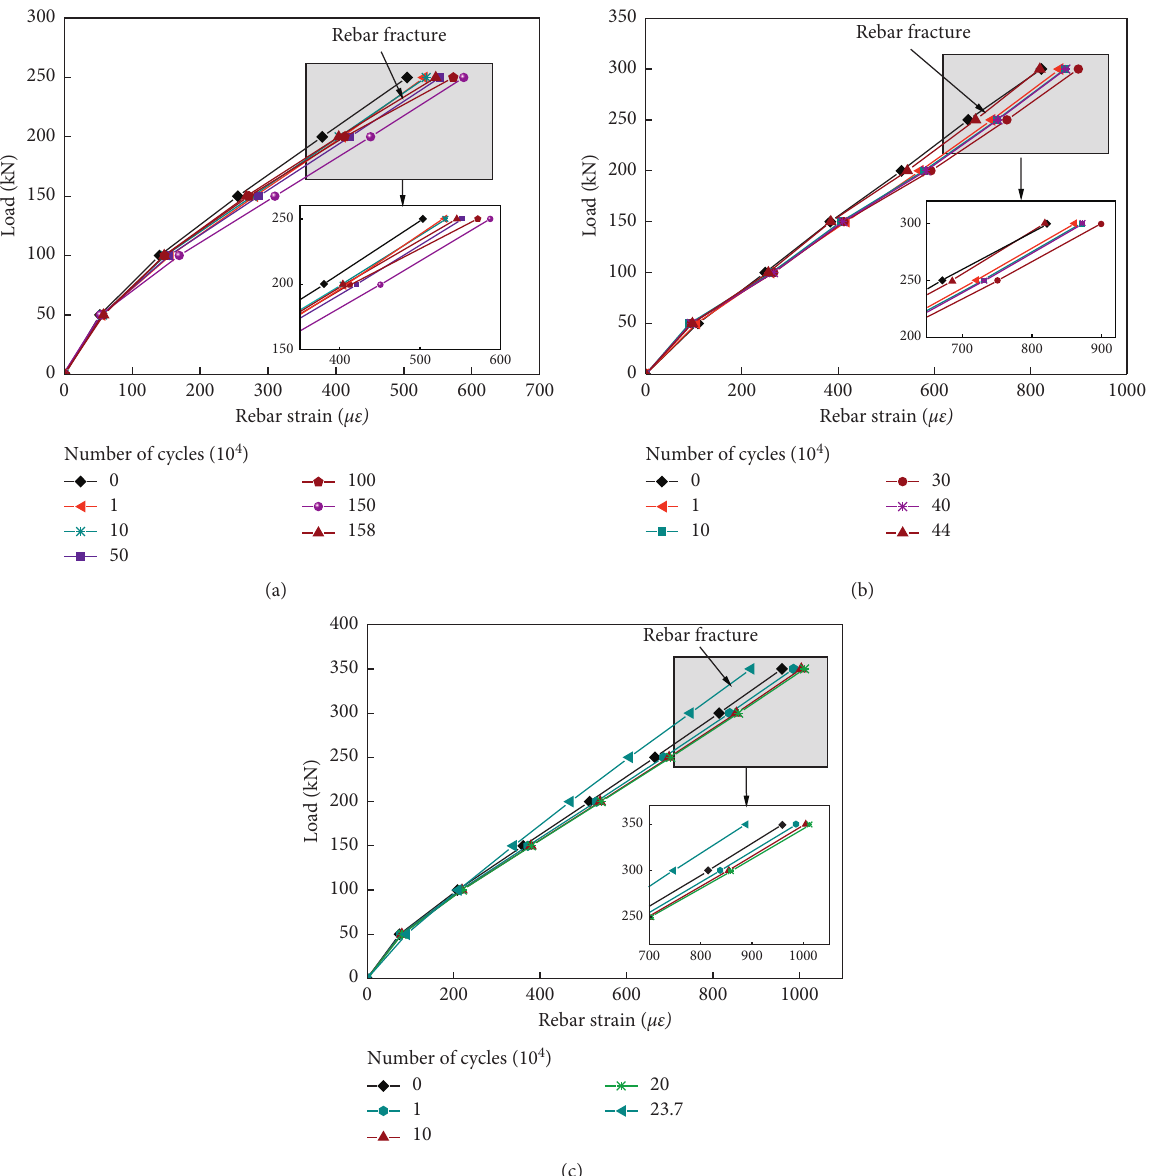
Figure 14: Load-midspan rebar strain in (a) JP1; (b) JP2; and (c)